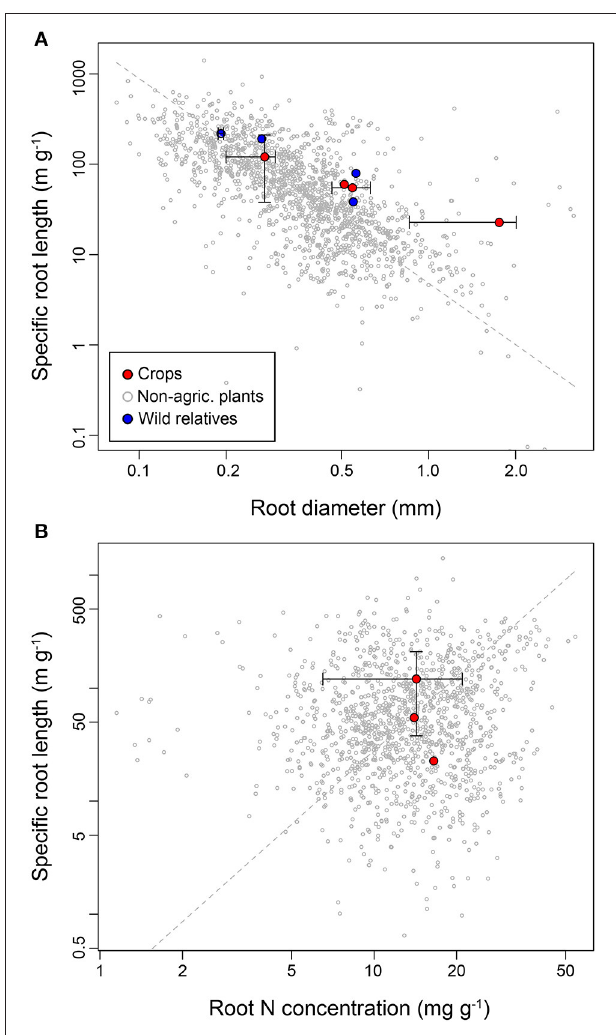
FIGURE 2 | Bivariate relationships among root traits [root diameter and specific root length (A) and root N and specific root length (B) ] of crops. In order to visualize the extent of root trait trade-offs, crops and their wild relatives are included, as well as trait relationships observed across the whole GRooT dataset ( Guerrero-Ramirez et al.,